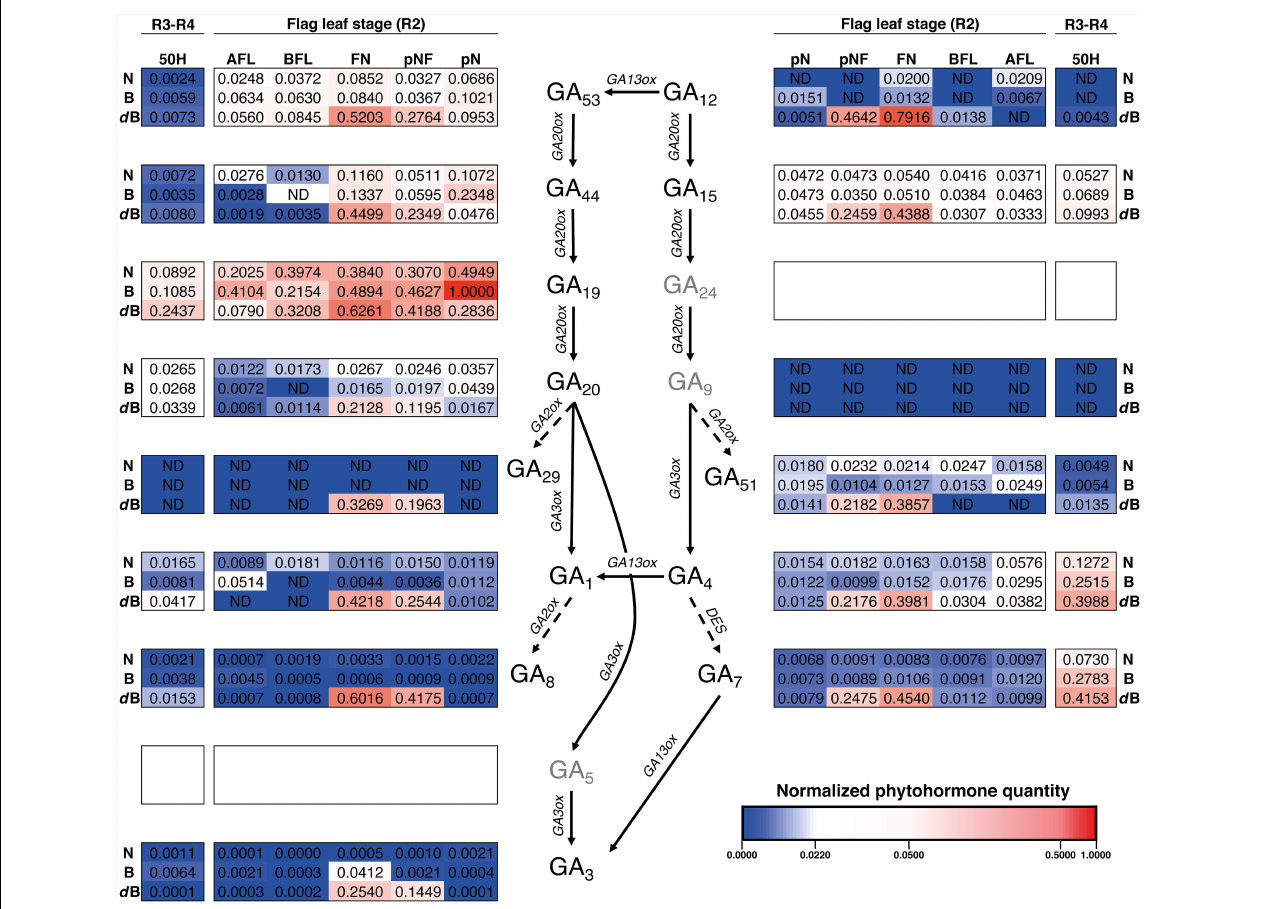
FIGURE 7 | Heatmap of the hormone profiling of the three Mediterranean japonica rice varieties in the stages R2 and R3-R4. Normalized phytohormone quantity scale is shown at the lower right of the image and corresponds to the mean of 3 replicates. Three phytohormones (GA 5 , GA 9 , and GA 24 , in gray) were not analyzed, ND, not determined phytohormone. N, NRVC980385; B, Bomba; d B, dwarf -bomba; pN, node previous to the flag leaf node; pNF, internode between flag leaf and previous leaf; FN, flag leaf node; BFL, basal part of the flag leaf; AFL, apical part of the flag